Question: What type of chart is this?
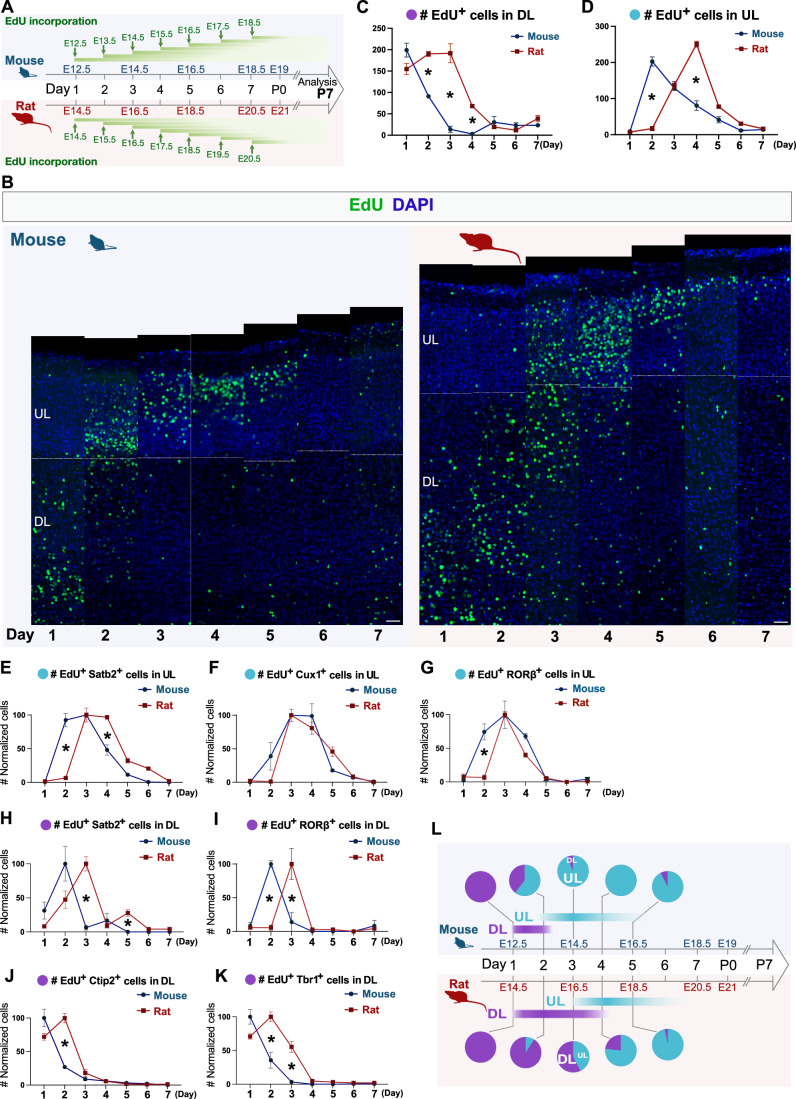
Answer: bar